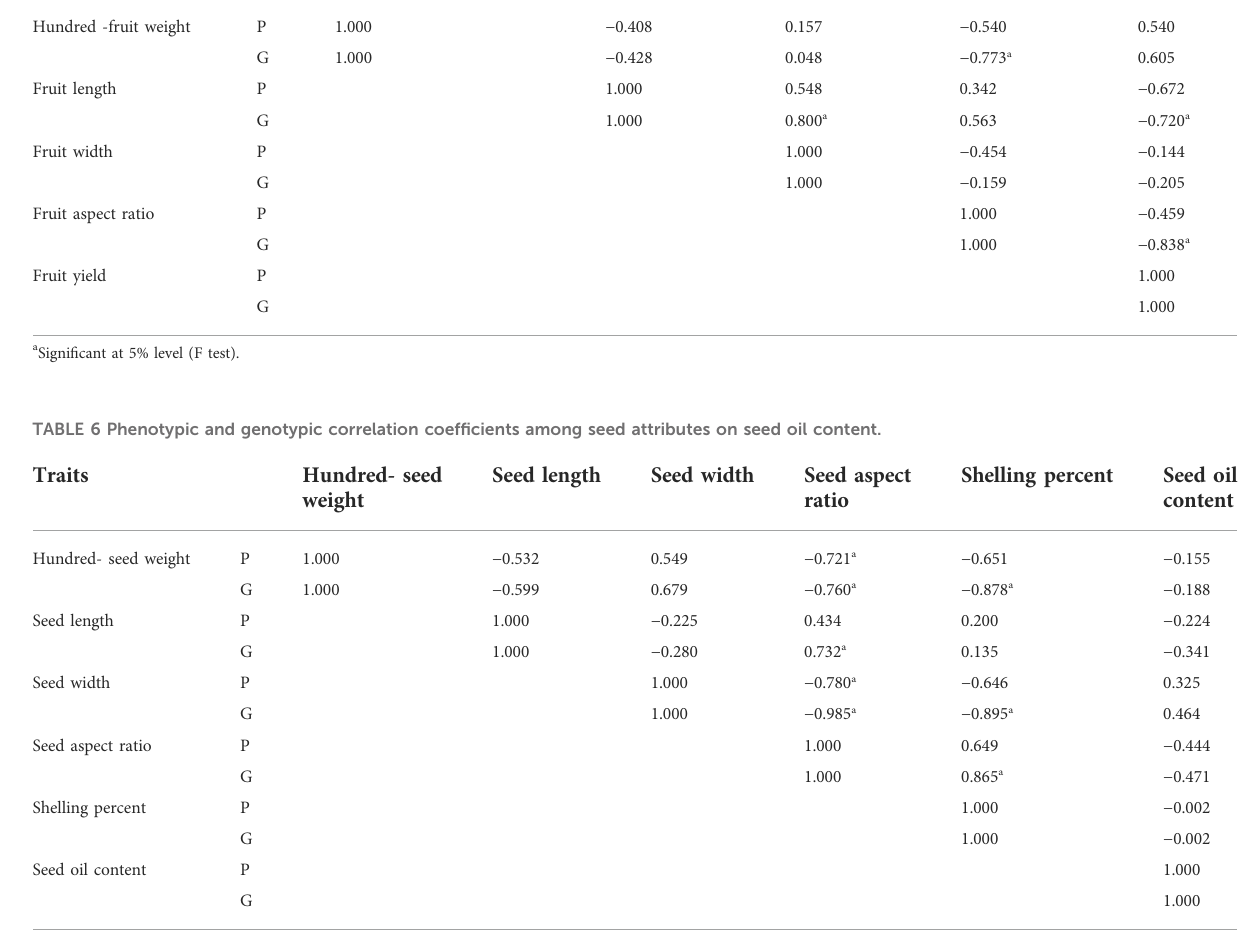
TABLE 5 Phenotypic and genotypic correlation coef fi cients among fruit attributes on fruit yield. Traits Hundred-fruit weight Fruit length Fruit width Fruit aspect Hundred -fruit weight